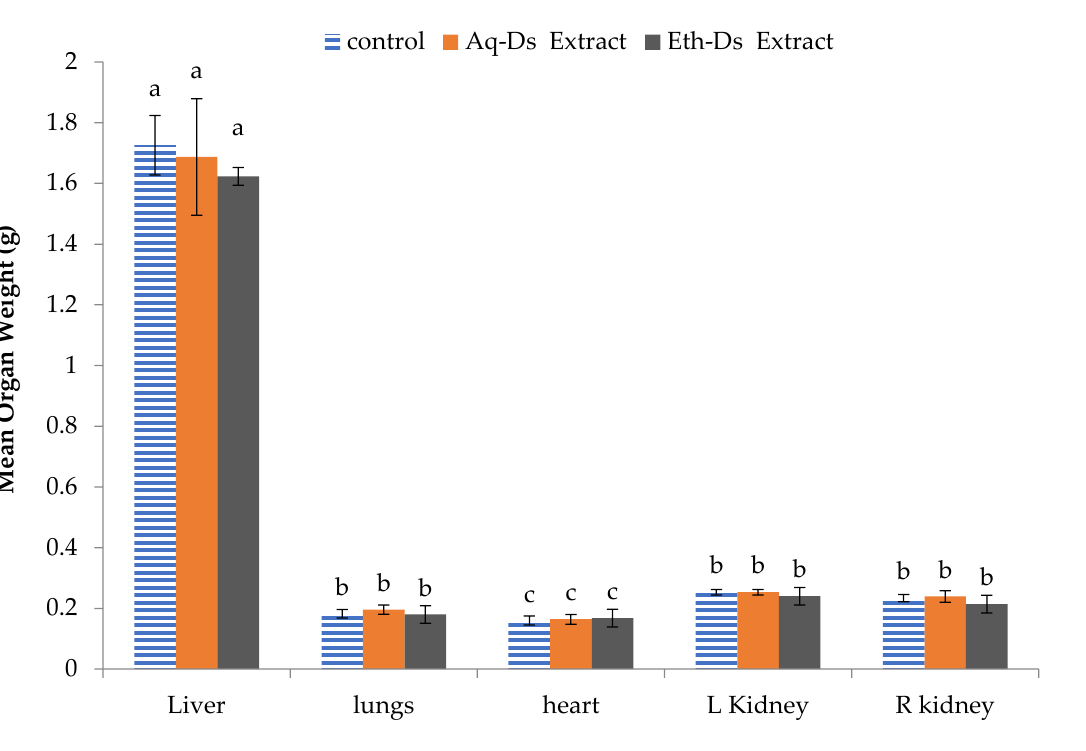
Figure 1. Mean organ weight of normal and extract-treated mice. No statistical difference was observed among the mice from control, Aq-DS or Eth-DS extract-treated mice liver, lungs, heart and kidneys. Groups: Eth-DS: Ethanolic extract of DS, Aq-DS: Aqueous extract of DS. Letter a, b or c above each bar is the standard error which indicates that the values are significant